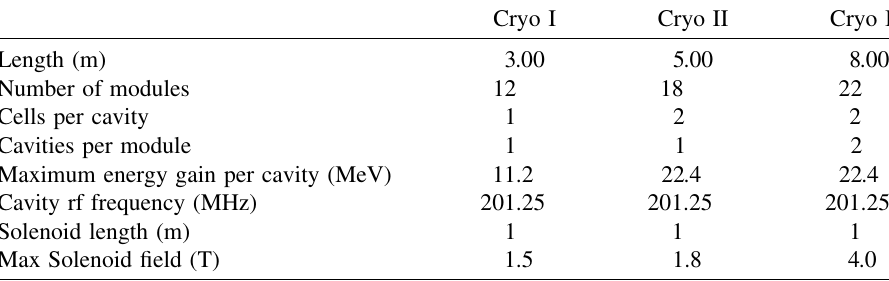
TABLE V. Linac cryomodule parameters.